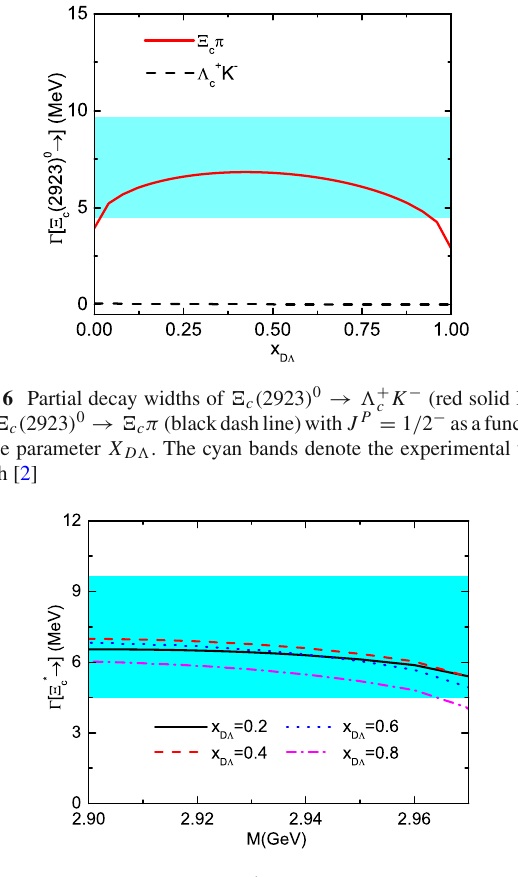
Fig. 7 Total decay width of the (cid:2) ∗ c as a function of the mass of bound state (cid:2) ∗ c and X D (cid:3) . The cyan bands denote the experimental total width of (cid:2) c ( 2923 )